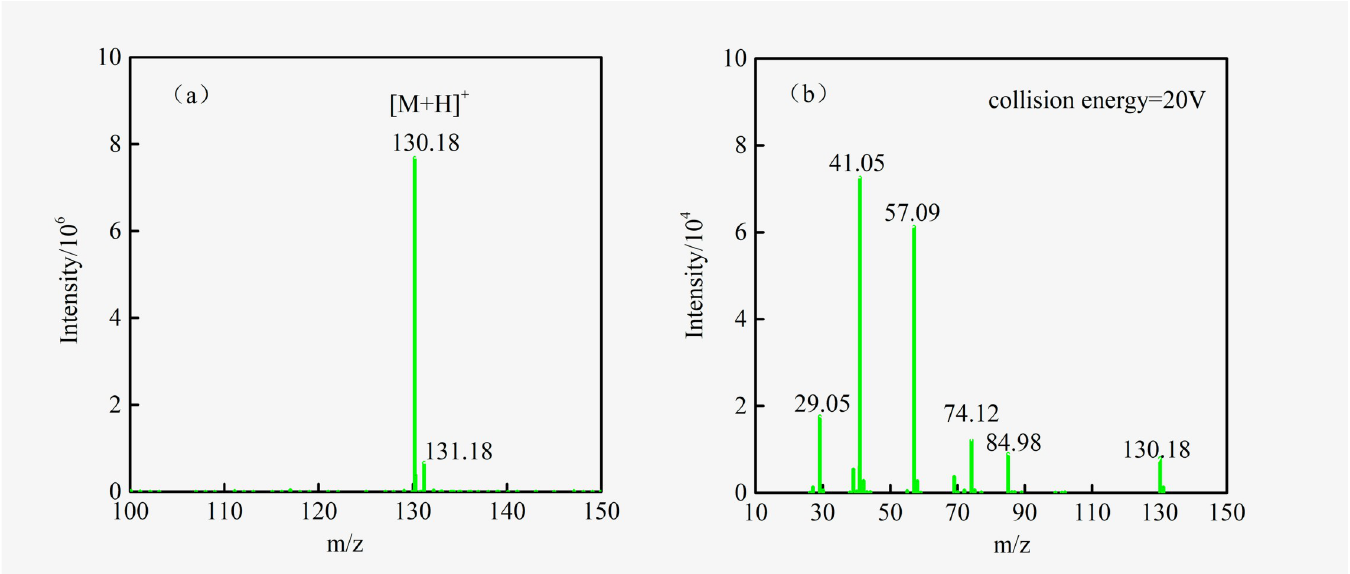
Fig 7. The MS(a) and MS/MS(b) spectrum of C 6 H 11 NO 2 .